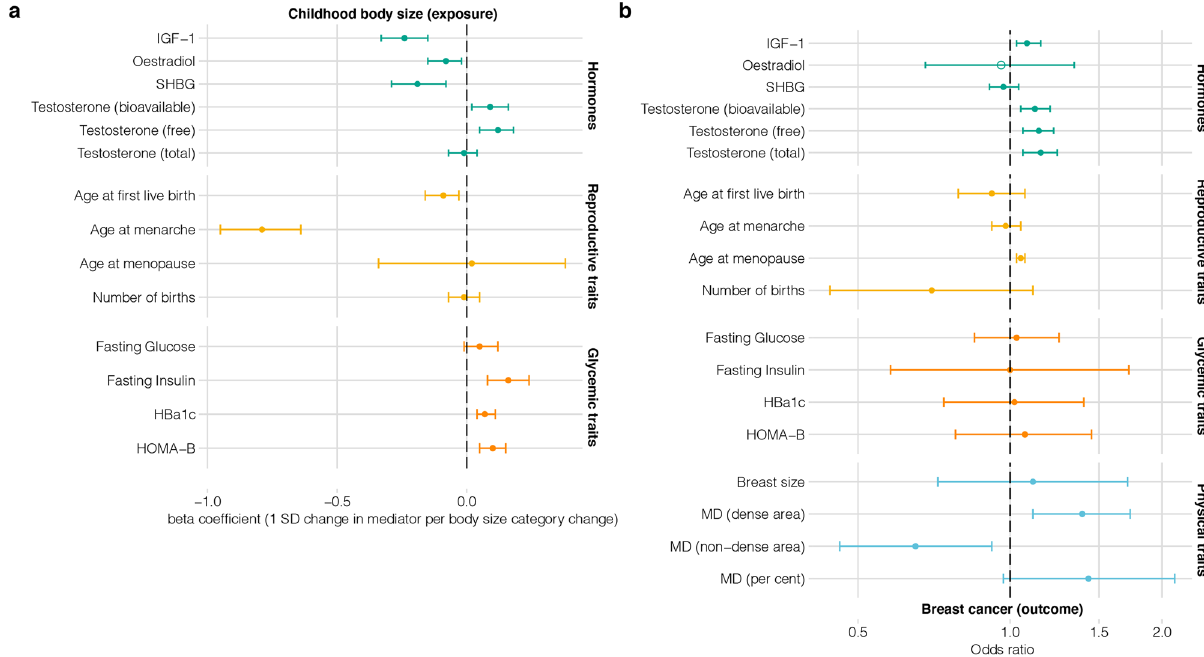
Fig. 3 Two-step Mendelian randomization results evaluating four groups of potential mediators (hormones, reproductive traits, glycaemic traits, physical traits). a Step 1: Plots showing the effect of childhood body size on the mediators (univariable MR). The effect is measured as the standard deviation (SD) change in mediator per body size category change. b Step 2: Plots showing the odds of breast cancer per SD higher mediators (unless otherwise speci fi ed in Table 1; univariable MR). Bars indicate 95% con fi dence intervals around the point estimates from IVW analyses (in step 1: effect size/beta, in step 2: odds ratio), except oestradiol (the estimate is based on a single Wald ratio and is indicated by an empty circle shape). MD − mammographic density. The presented data is available in Supplementary Data 1 and 2. The details about the datasets are provided in Table